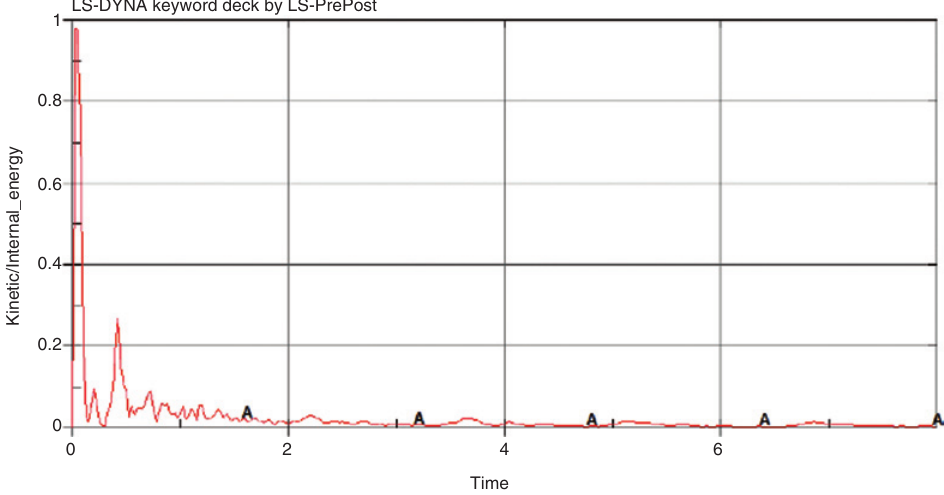
Figure 3 Typical graph of internal energy as the function of time.